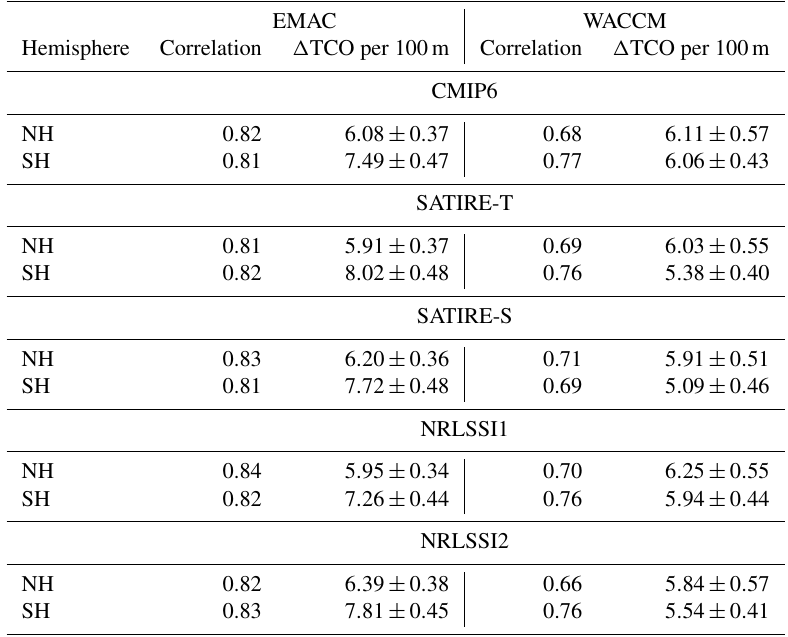
Table 2. Correlations of annual average polar region (70–90 ◦ N) anomalies (solar maximum – solar minimum) of total column ozone (TCO) and the layer thickness from 100 to 10hPa. TCO change in DU per 100m geopotential height change and the 95% confidence